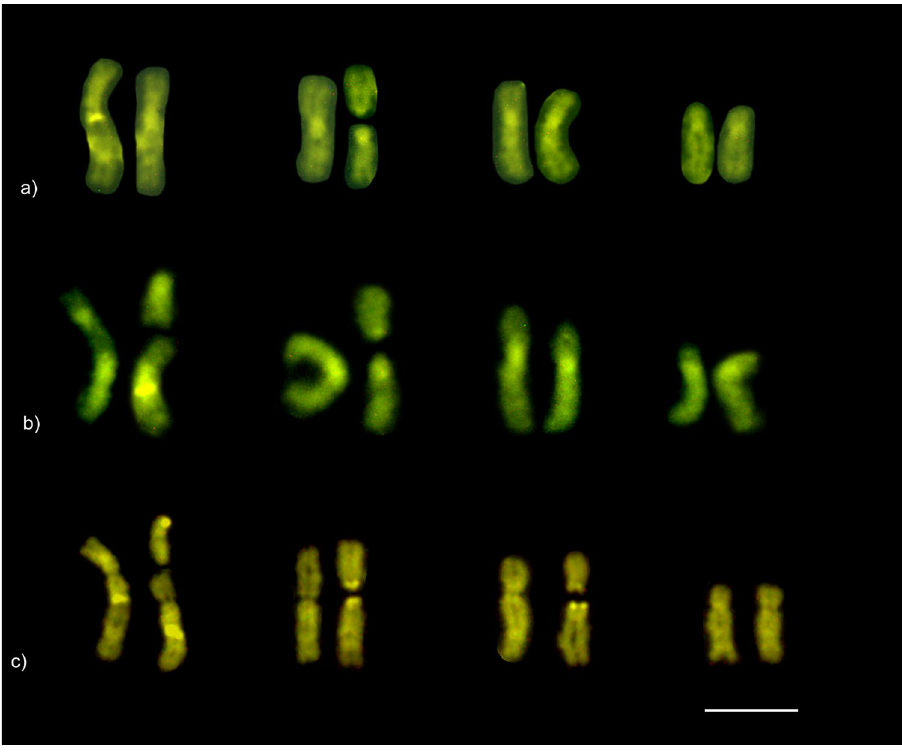
Figure 5. Karyotypes of Mycocepurus smithii from the asexual population stained with CMA 3 . ( a ) Karyomorph 2n = 9; ( b ) karyomorph 2n = 10; ( c ) karyomorph 2n = 11. Scale bar represents 5 µm.